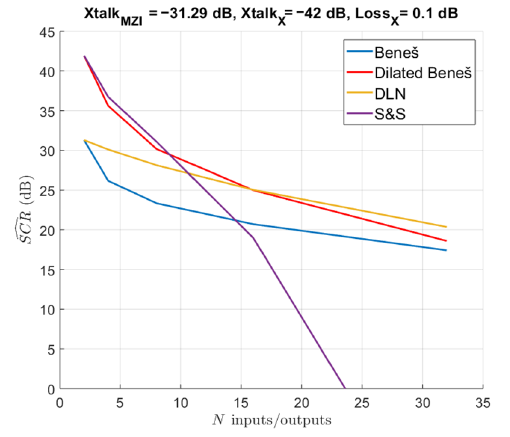
Figure 10. (cid:1845)(cid:1829)(cid:1844)(cid:3554) expected using our technology. Figure 10. ˆ SCR expected using our